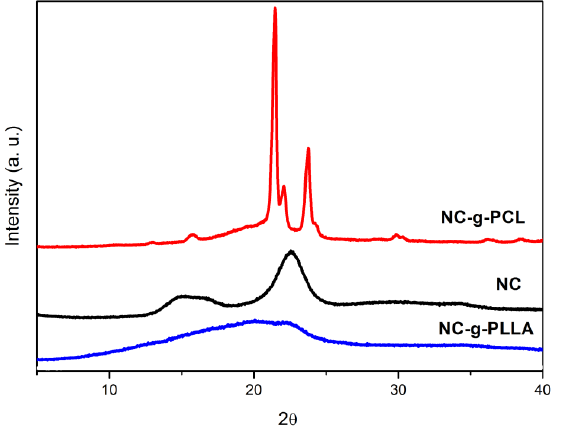
Figure 7. X-ray diffraction spectra for neat NC, NC-g-PCL, and NC-g-PLLA.